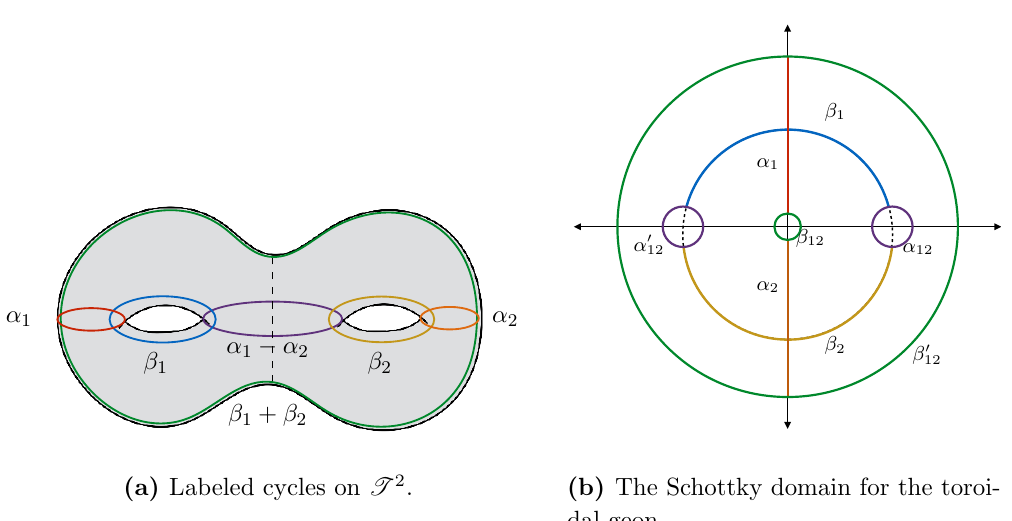
(b) The Schottky domain for the toroi- dal geon. . i = t =0